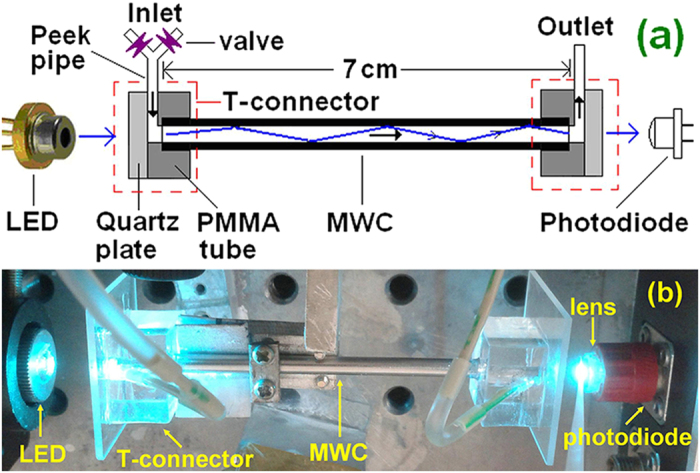
(a) Schematic diagram and (b) optical image of the MWC-based photometer.